Question: Summarize what this figure shows in one sentence.
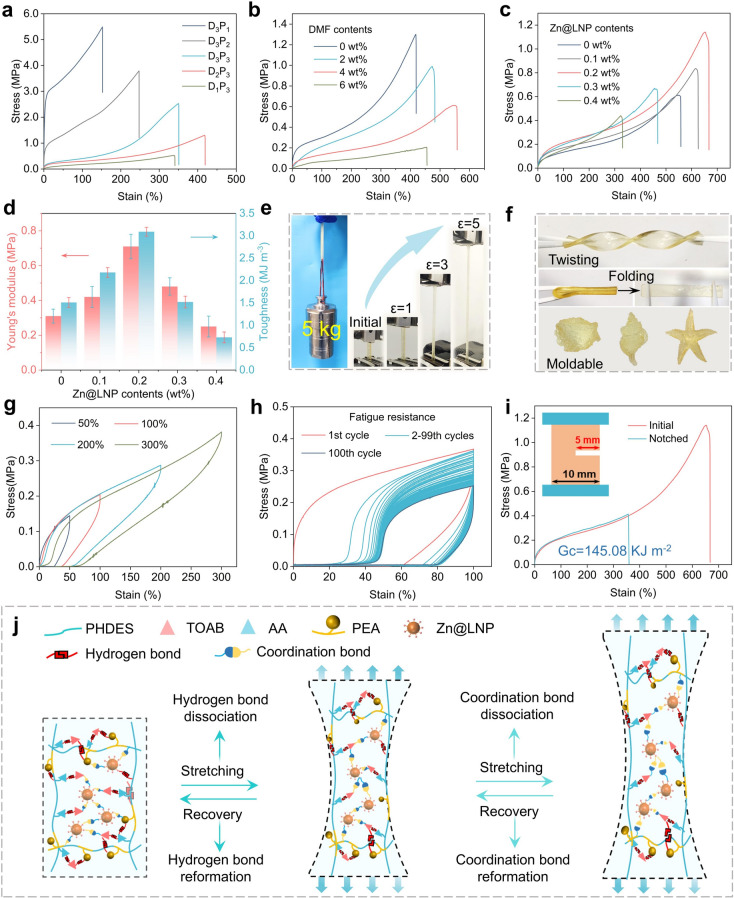
Answer: Mechanical properties of DPF-Zn@LNP-HEG. a–c Stress–strain curves with varying PHDES/PEA mass ratios (for DP-HEG), DMF contents (for DPF-HEG), and Zn@LNP contents. d Young’s modulus and toughness as a function of Zn@LNP contents. e Photographs demonstrating high mechanical strength. f Photographs showing moldability, torsion behavior, and foldability with full recovery. g Tensile loading–unloading curves at different strains. h Cyclic tensile loading–unloading curves over 100 cycles at 100% strain. i Stress–strain curves of unnotched and notched samples. j Schematic of the structural evolution in the DPF-Zn@LNP-HEG network